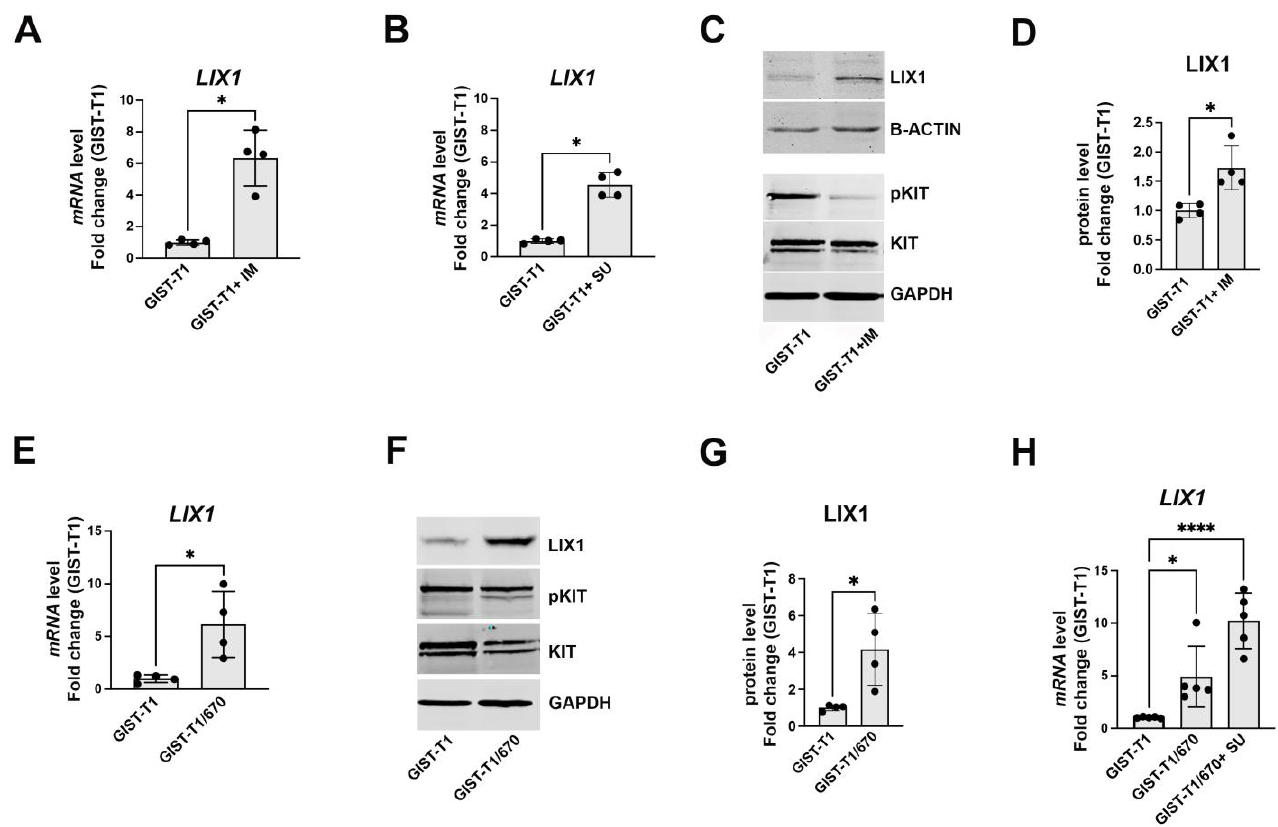
Figure 1. LIX1 expression is increased in GIST cells upon KIT-signaling inhibition using TKI. ( A , B ) RT-qPCR analysis of LIX1 transcript levels in GIST-T1 cells cultured in the presence of 0.5 µ M imatinib ( A ) or 0.5 µ M sunitinib for 48 h ( B ). Data were normalized to the mean HMBS and YWHAZ expression and converted to fold change. Values are the mean ± SEM of four independent experiments; * p < 0.05 (two-tailed Mann–Whitney test). ( C ) Representative western blot showing LIX1, phosphorylated KIT (pKIT), and KIT levels in GIST-T1 cells cultured with 0.5 µ M imatinib for 48 h. Equal loading was verified by GAPDH expression. ( D ) Quantification of LIX1 level normalized to GAPDH level. Normalized expression levels were converted into fold change. Values are the mean ± SEM of four independent experiments; * p < 0.05 (two-tailed Mann–Whitney test). ( E ) RT-qPCR analysis of LIX1 transcript levels in GIST-T1 and imatinib-resistant GIST-T1/670 cells. Data were normalized to the mean HMBS and YWHAZ expression and converted to fold changes. Values are the mean ± SEM of four independent experiments; * p < 0.05 (two-tailed Mann–Whitney test). ( F ) Western blot analysis of endogenous LIX1 levels in GIST-T1 and GIST-T1/670 cells. ( G ) Quantification of LIX1 level normalized to GAPDH level. Normalized expression levels were converted into fold change. Values are the mean ± SEM of four independent experiments; * p < 0.05 (two-tailed Mann–Whitney test). ( H ) RT-qPCR analysis of LIX1 transcript levels in GIST-T1 cells, GIST-T1/670 cells, and GIST-T1/670 cells cultured in the presence of sunitinib for 48 h. Data were normalized to the mean HBMS and YWHAZ expression and converted to fold change. Values are the mean ± SEM of five independent experiments; * p < 0.05; **** p < 0.0001 (one-way ANOVA test followed by Dunnett’s multiple comparisons